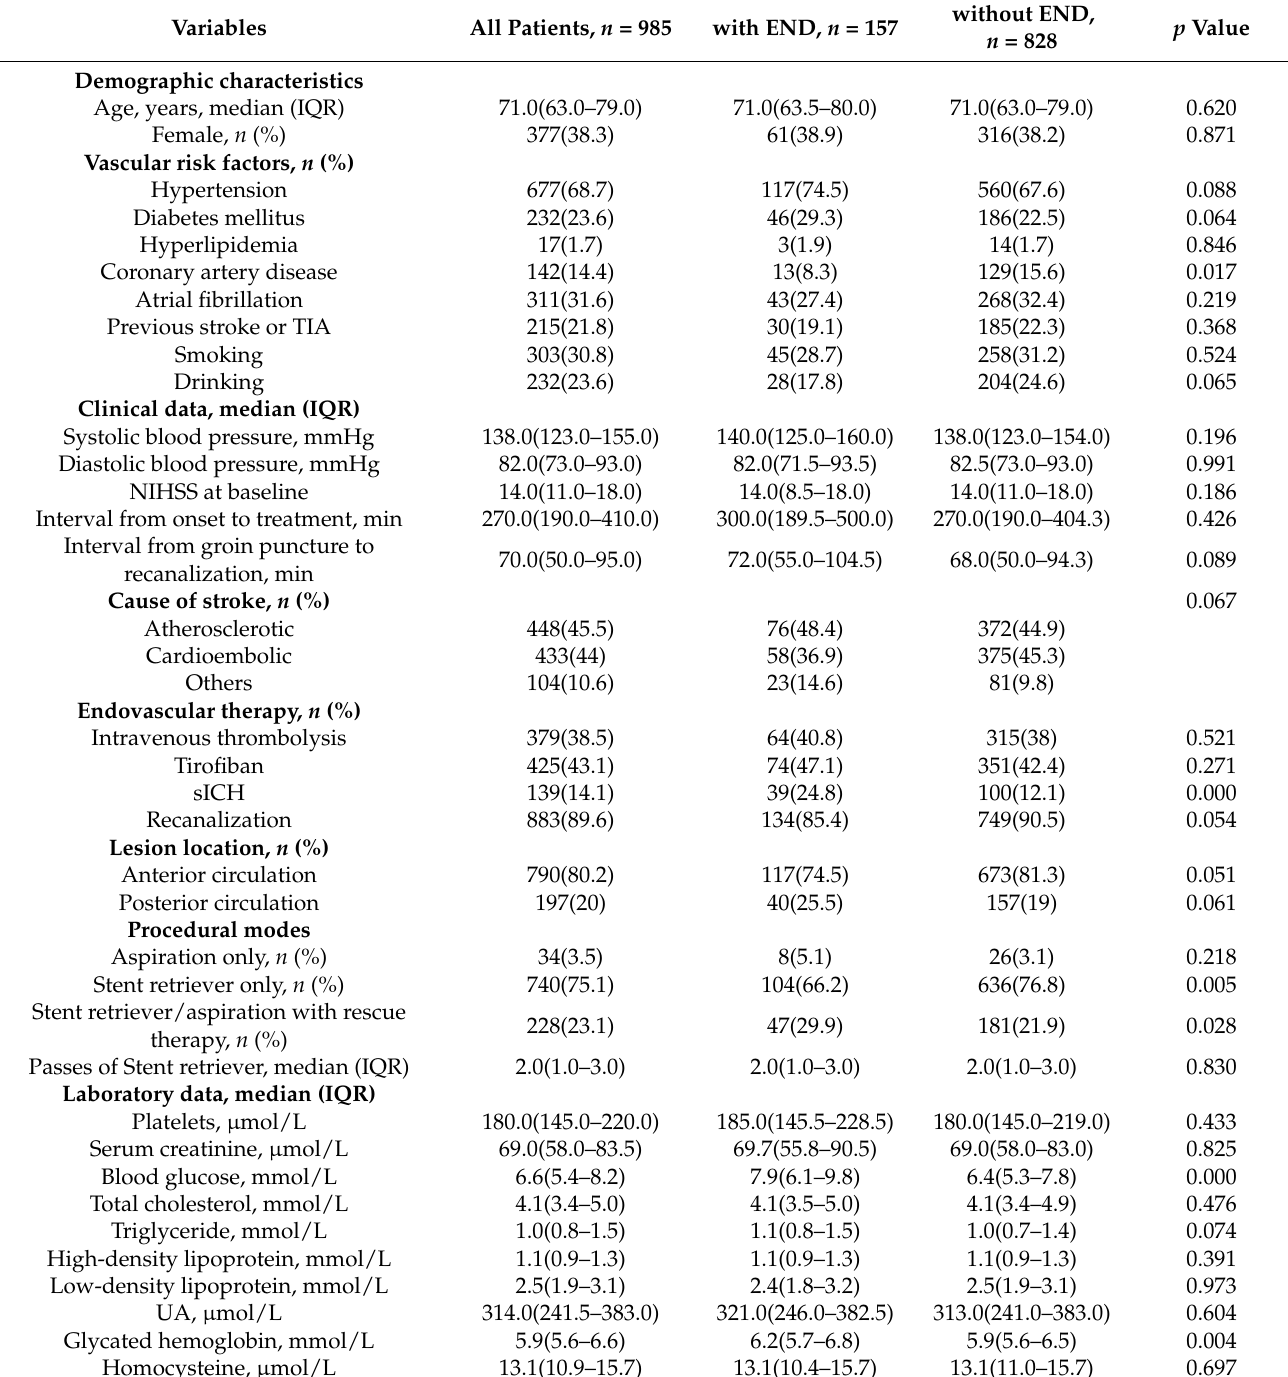
Table 1. Demographics and clinical characteristics according to patients with and without early neurological